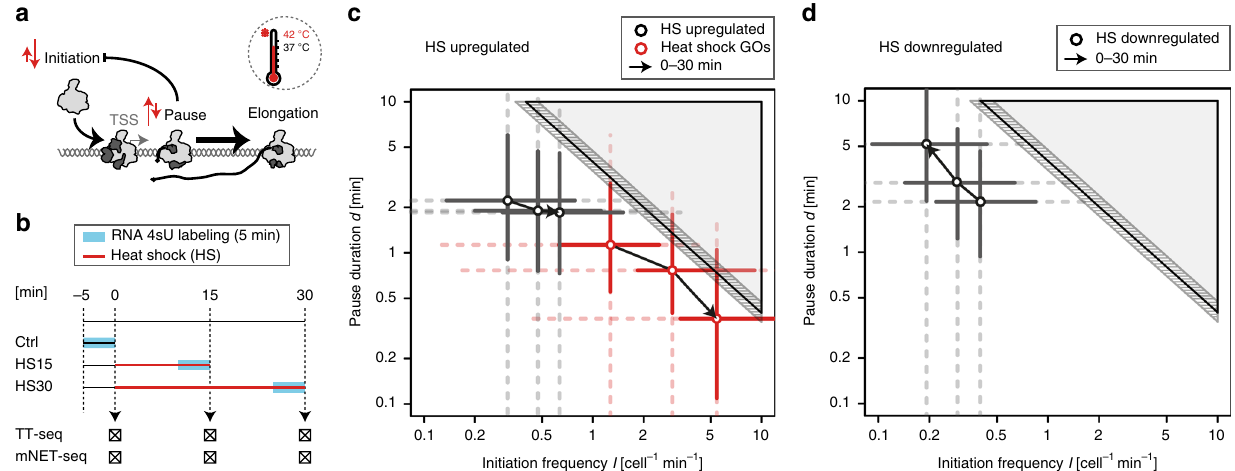
Fig. 3 Regulation of transcription upon heat shock timecourse in human K562 cells. a Illustration of the regulatory changes (red arrows) at a model gene upon heat shock. Pol II is depicted in silver, decorated with initiation, pausing or elongation factors (dark gray). b Experimental setup of the heat shock (HS) timecourse (0 – 30 min at 42 °C) in human K562 cells. TT-seq and mNET-seq experiments were performed in two independent biological samples (Supplementary Table 1; Supplementary Fig. 1). c Pause-initiation trajectories upon heat shock timecourse. Shown are 706 signi fi cantly upregulated cTUs (in gray), and 33 signi fi cantly upregulated RefSeq-TUs (in red) of overrepresented GO categories linked to heat shock (unfolded protein binding, regulation of cellular response to heat, response to unfolded protein, and chaperone binding) (Supplementary Fig. 7). Median estimates per time point (0, 15, and 30 min) are depicted as circles. The two solid perpendicular lines de fi ne the interquartile range, and the dotted whiskers represent 1.5 times the interquartile range of the respective estimates for the entire transcript class. The gray shaded area depicts impossible combinations of I and d 27,28 . Striped area shows con fi dence intervals of the pause-initiation limit. d Pause-initiation trajectories as in c upon heat shock timecourse of 1907 signi fi cantly downregulated cTUs (in